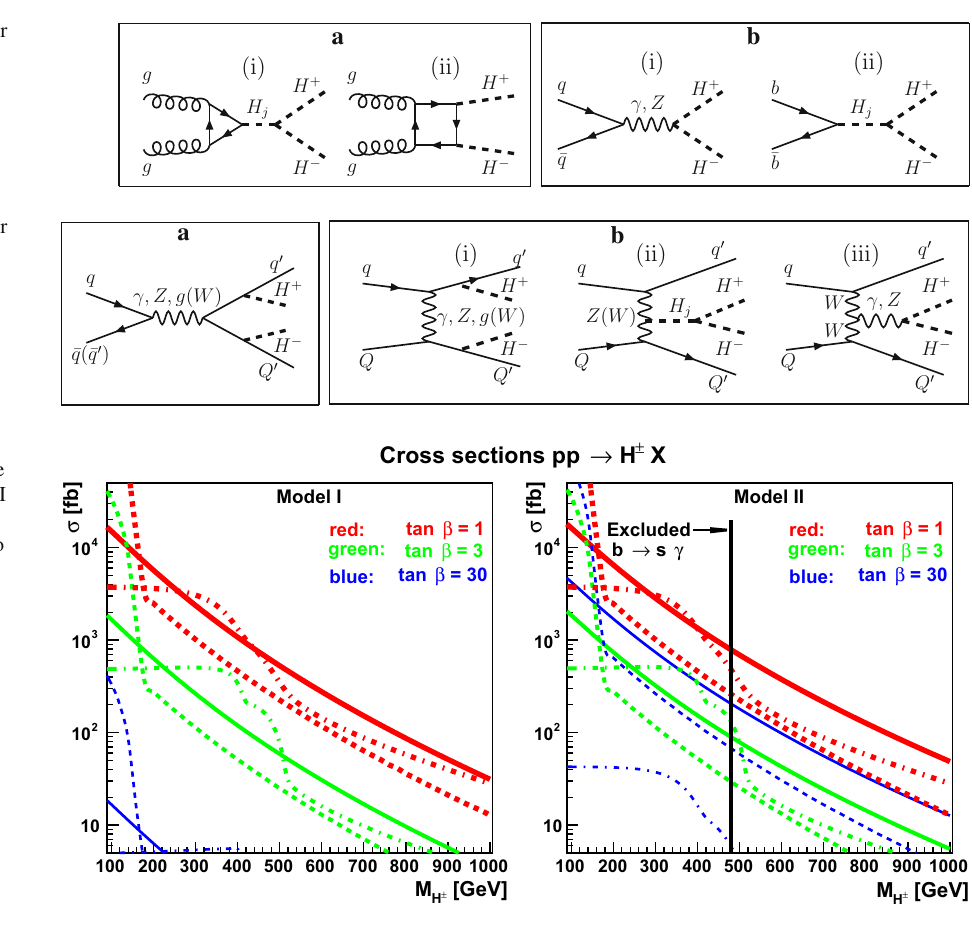
Fig. 13 Feynman diagrams for the pair production processes (6.10a)